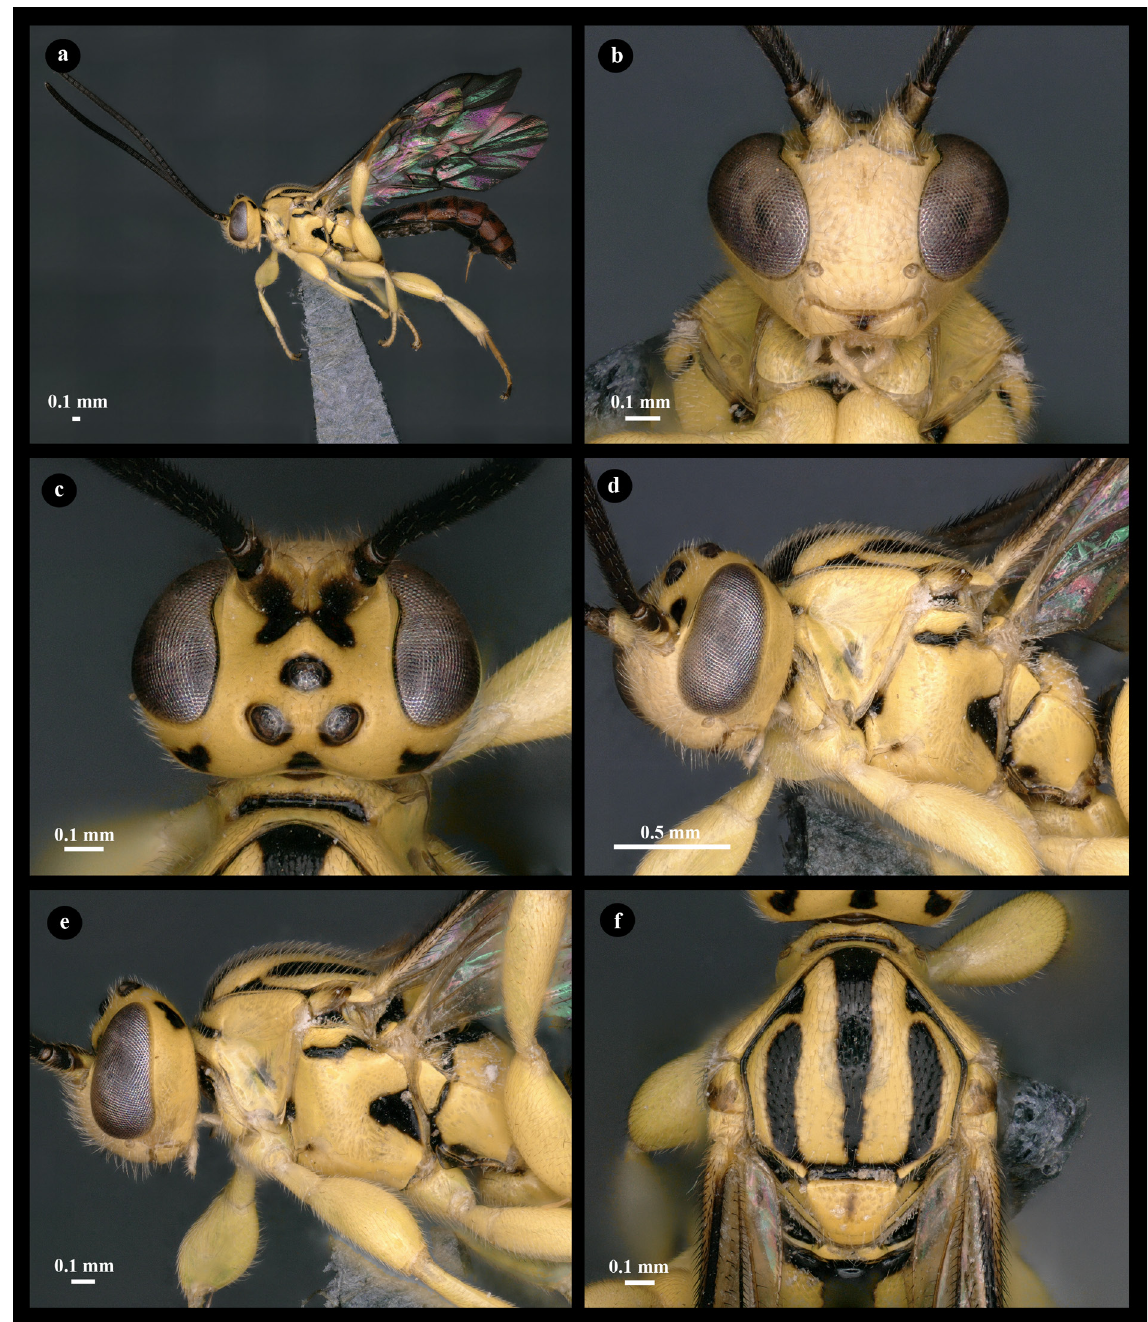
Fig. 17. Soliga ecarinata gen. et sp. nov., holotype, ♀ (AIMB). a . Habitus, lateral view. b . Head, anterior view. c . Head, dorsal view. d . Head and mesosoma, oblique view. e . Head and mesosoma, lateral view. f . Mesosoma, dorsal